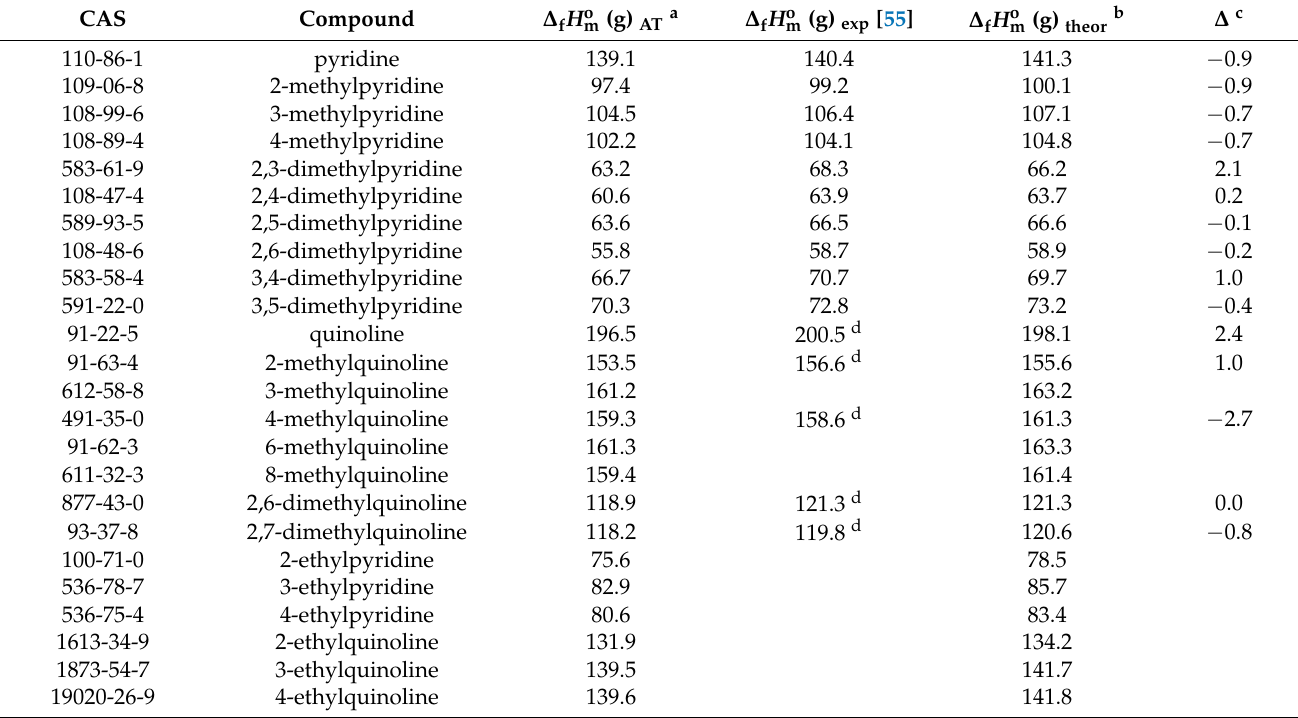
a Calculated by the G4 method according to the standard atomization procedure. b Results from atomization reaction were corrected with help of following equation: ∆ f H o m (g) theor /kJ.mol − 1 = 0.9893 × ∆ f H o m (g, AT) + 3.7 with R 2 = 0.9991 (the expanded uncertainty assessed to